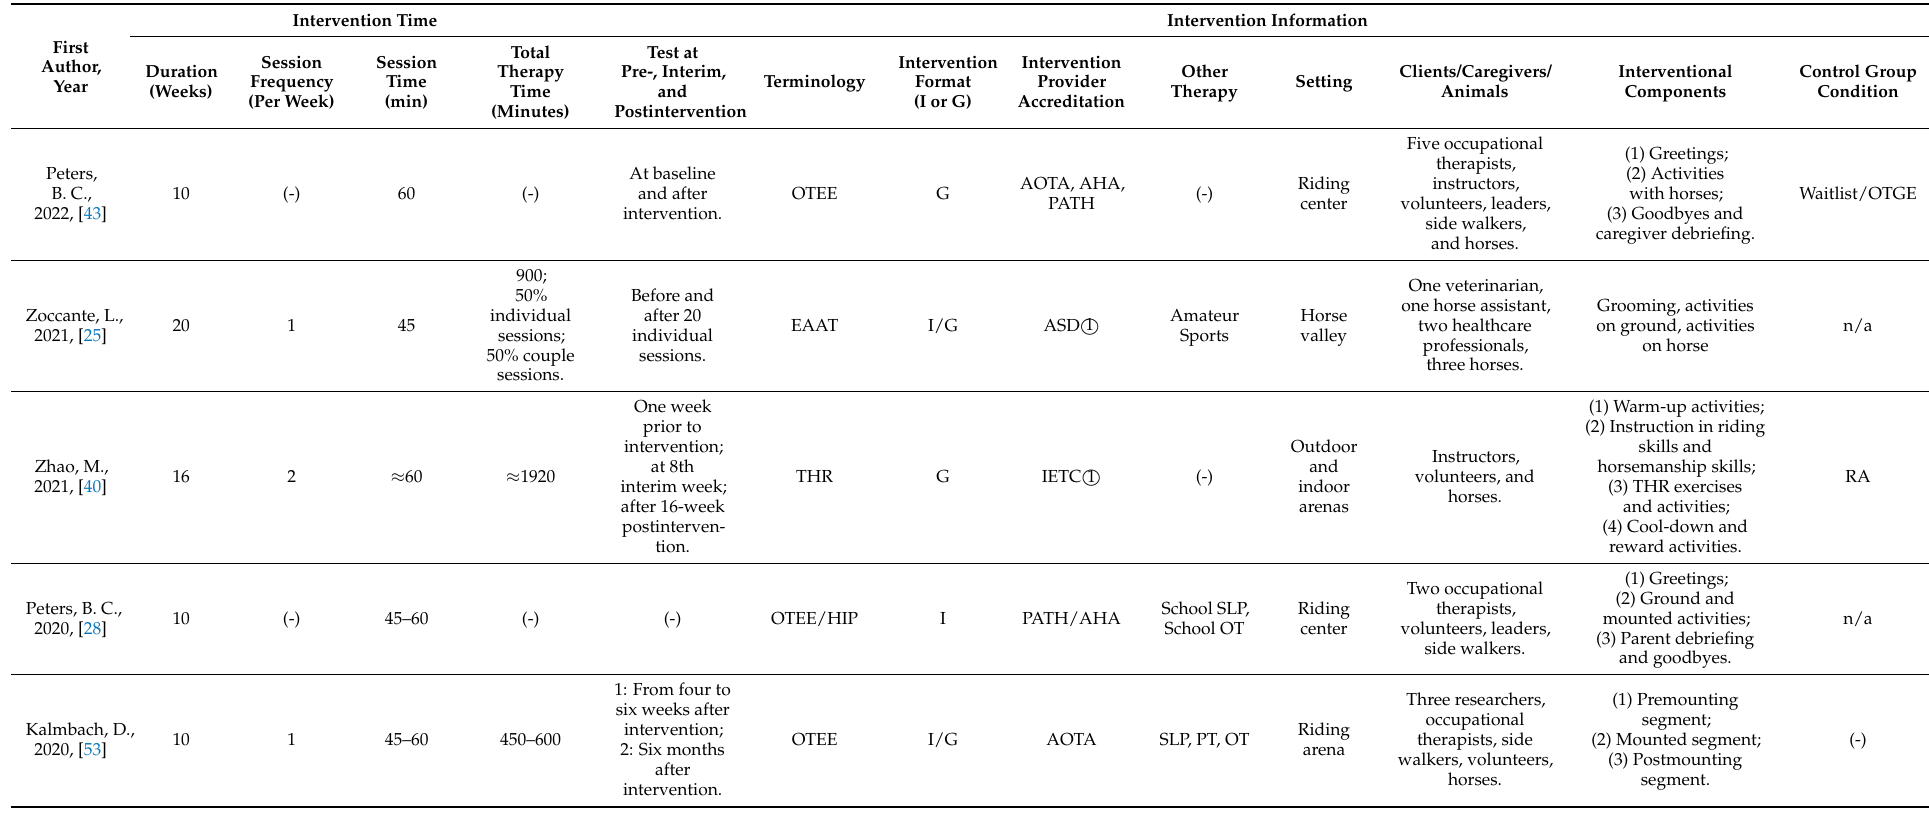
Table 3. Intervention